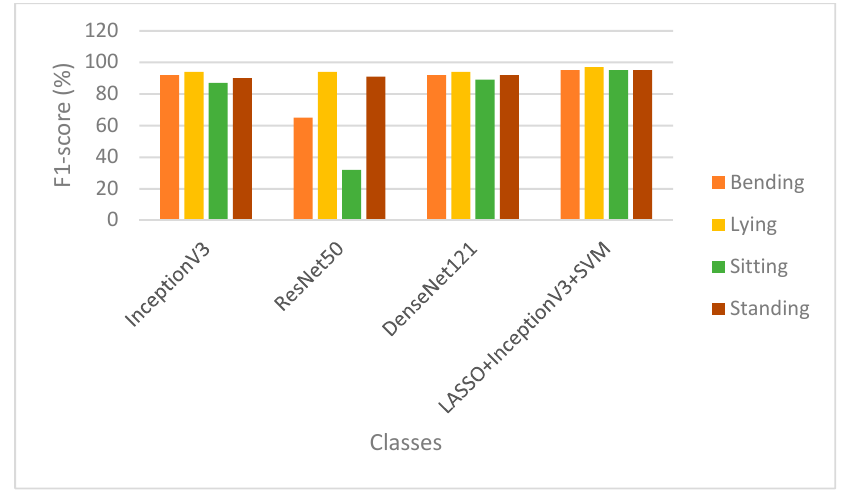
Figure 7. F1 score per class classification result .